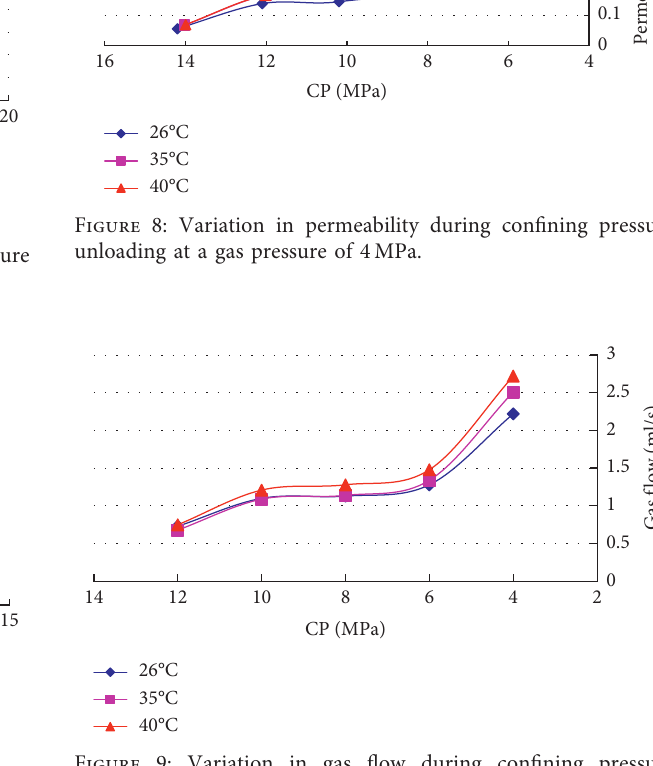
Figure 6: Gas desorption velocity curves under different tem- perature conditions.